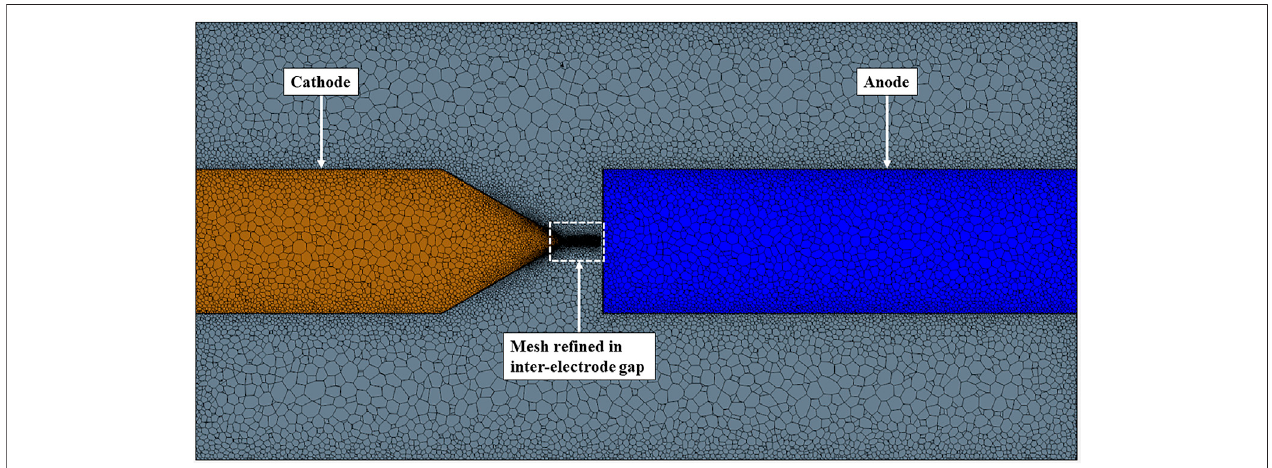
FIGURE 2 | The generated volume